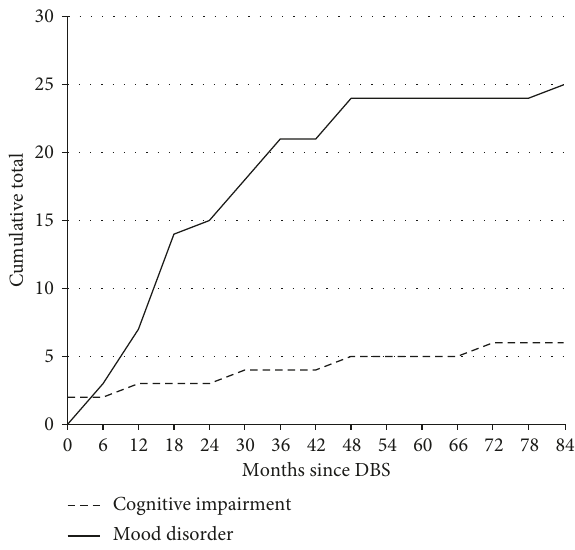
Figure 1: Cumulative cases of cognitive impairment and mood disorder as a function of time following DBS.